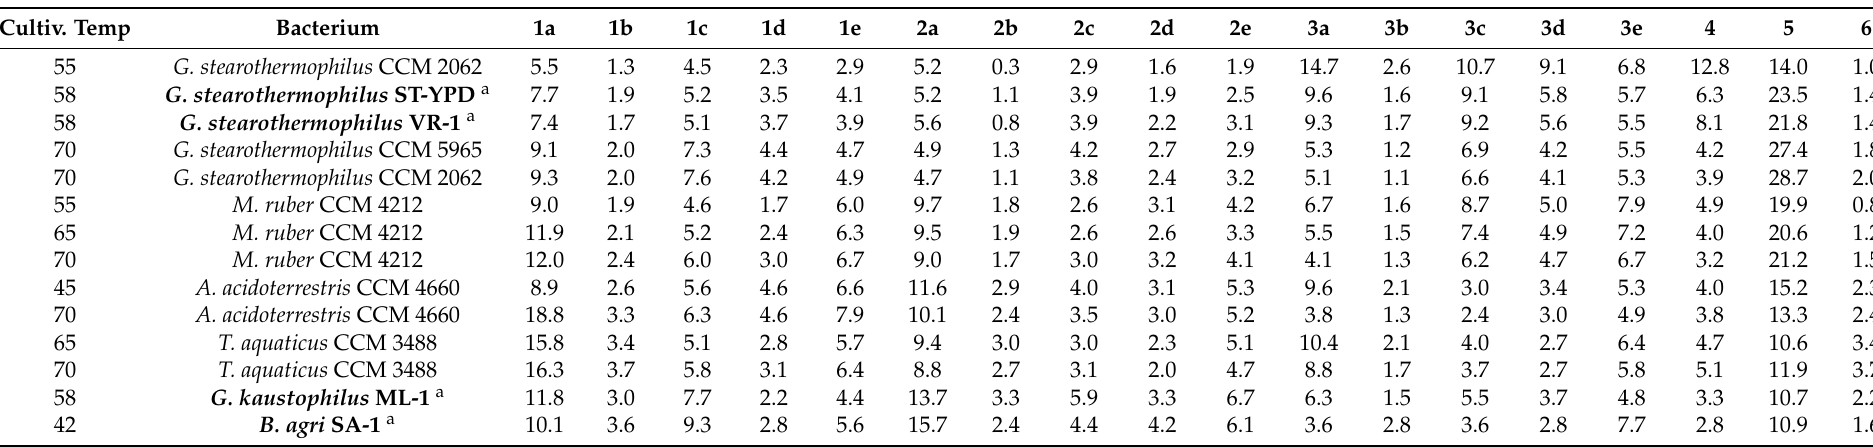
Table 3. Content (relative %) of hopanoids from fourteen strains of thermophilic bacteria identified by reverse-phase liquid chromatography–positive electrospray mass spectrometry (see Materials and